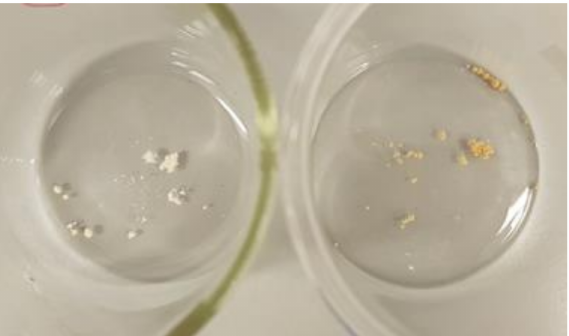
Figure 12. Photo of amikacin samples after heat treatment, after 10 min ( left ) and 30 min ( right ) at 195 ◦ C.